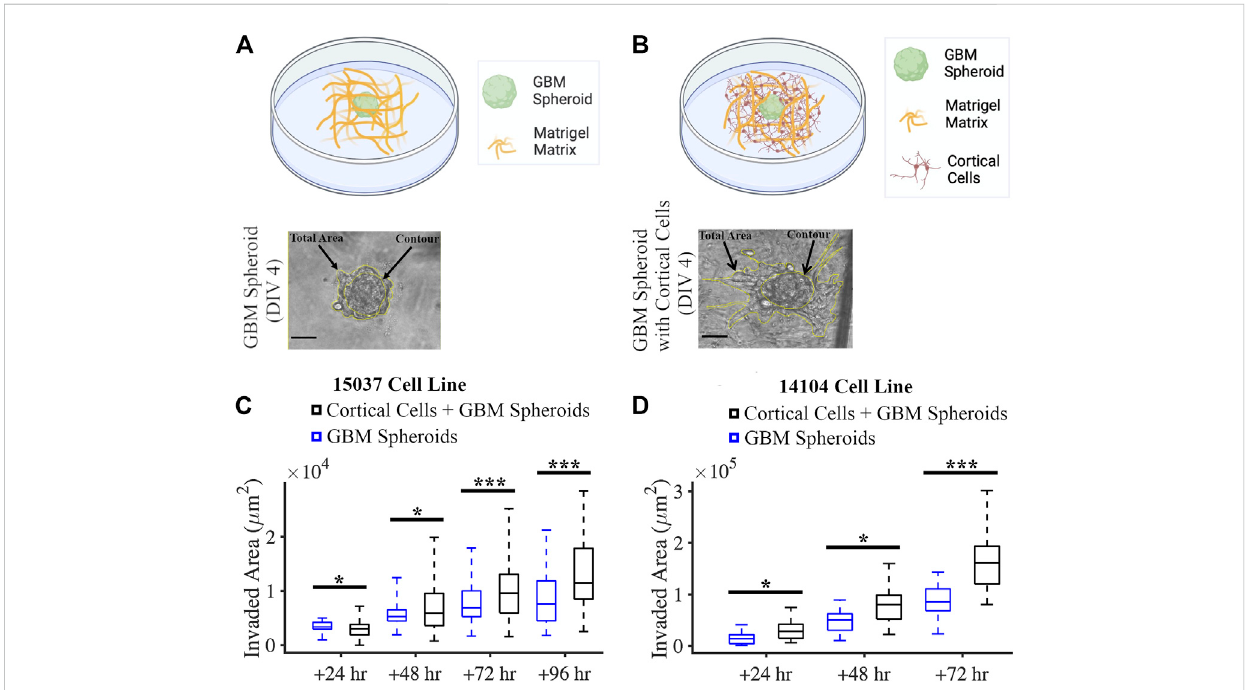
FIGURE 5 Co-culture of GBM spheroid embedded in Matrigel matrix mixed with cortical cells. (A) Schematic and a phase micrograph of a GBM spheroid in Matrigel on DIV 4. (B) Schematic and aphase micrograph of a GBM spheroid co-cultured with cortical cells embedded in Matrigel matrix on DIV 4. Phase micrographs illustrate the invaded area in each culture condition calculated as the difference between the total area and contour. (C) Boxplots of the invadedareaofGBMspheroidswithandwithoutcortical cellsoverdifferenttimepointsforthe15-037GBMcellline.N=58GBMspheroidswithout cortical cells and n = 74 GBM spheroids with cortical cells. KS test was used to measure statistical signi fi cance. * p < 0.05, ** p < 0.01 and *** p < 0.001. (D) Boxplot of the invaded area of GBM spheroids with and without cortical cells over different time points for the 14-104s GBM cell line. N = 25, 19, 14 GBM spheroids without cortical cells at 24 h, 48 h, and 72 h, respectively. N = 18, 18, 14 GBM spheroids with cortical cells at 24 h, 48 h, and 72 h, respectively. KS test was used to measure statistical signi fi cance. * p < 0.05, ** p < 0.01 and *** p <